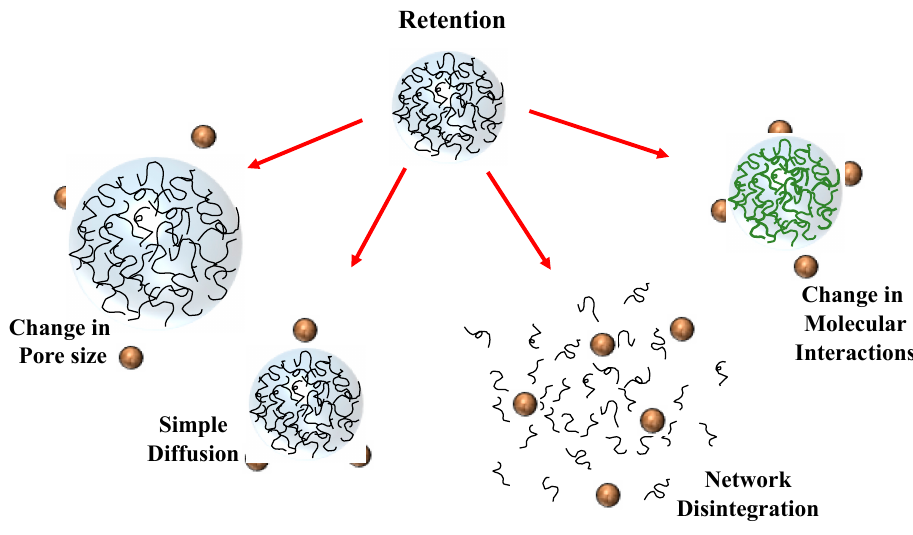
Figure 4. Colloidal particles can be designed to release encapsulated BPPs through various mechanisms, including changes in molecular interactions, pore size, network disintegration, or simple di ff